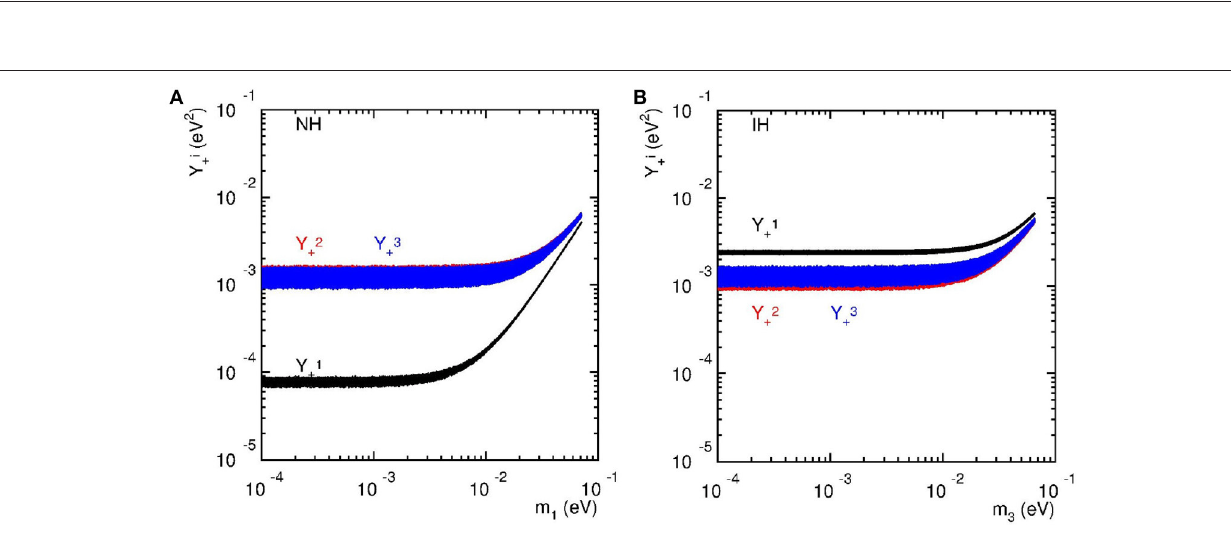
FIGURE 23 | Constraints on the diagonal (A,B) and off-diagonal (C,D) elements of the neutrino mass matrix M ν (A,C) and IH (B,D) when 8 1